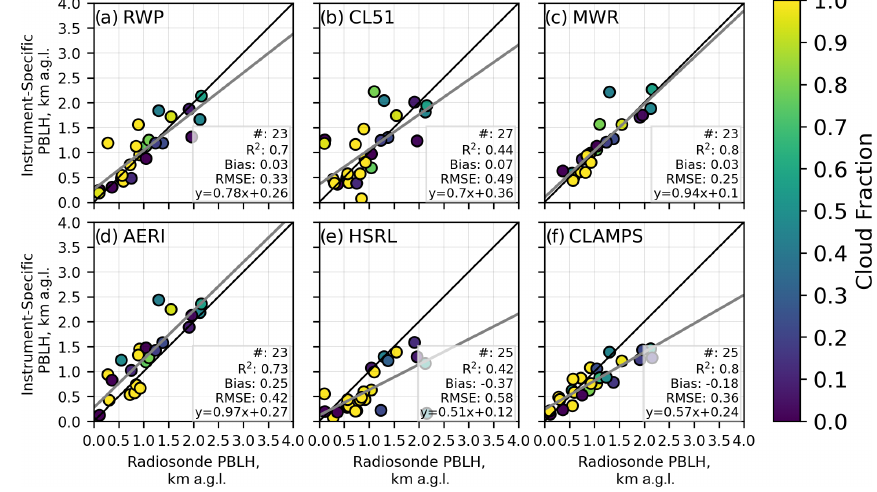
Figure 13. The same as in Fig. 12 but for the period of Fall-IOP and with CLAMPS included. Black lines represent the 1-to-1 line, and grey lines represent the best-fit line.